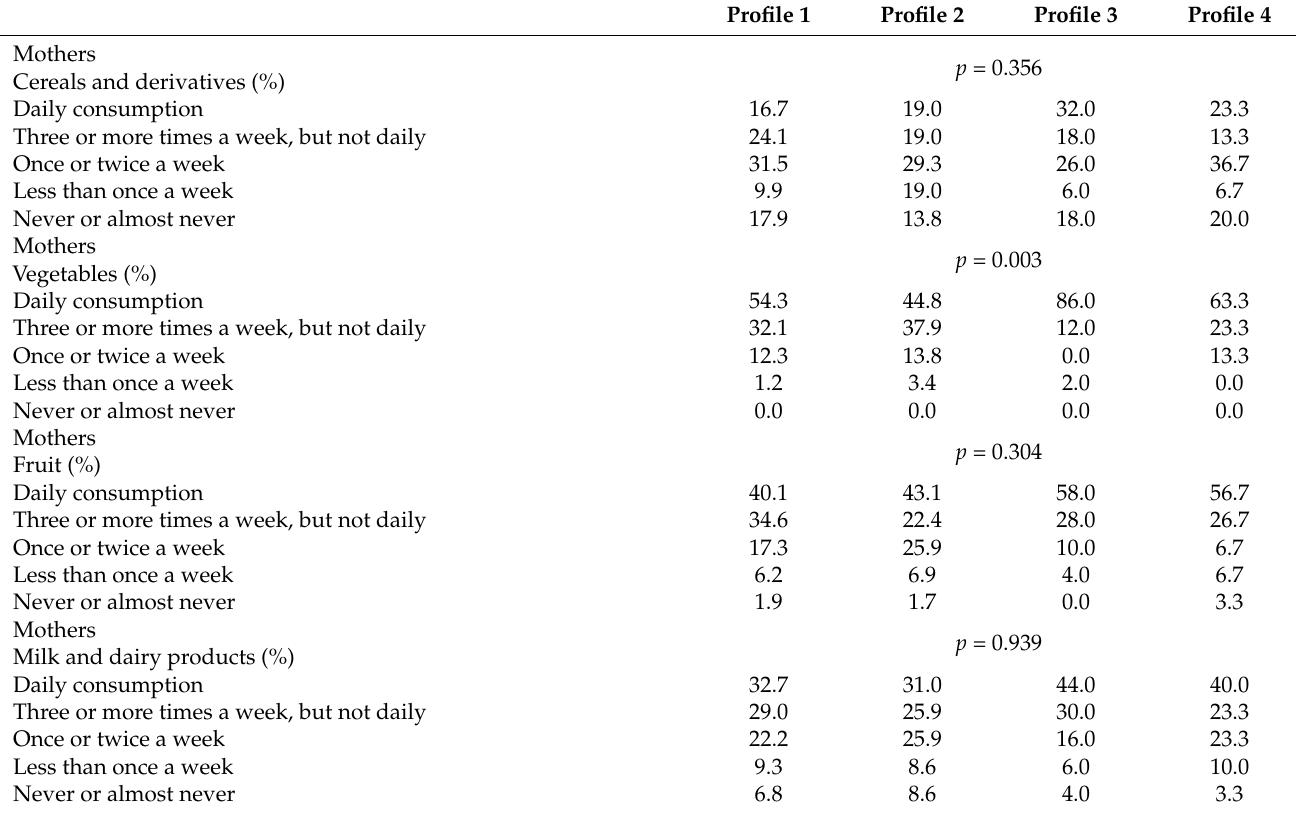
Table 6. Differences (%) between the four latent profile classes the consumption frequency of the foods included in the adapted healthy eating index (AHEI) according for mothers, fathers and adolescents. Profile